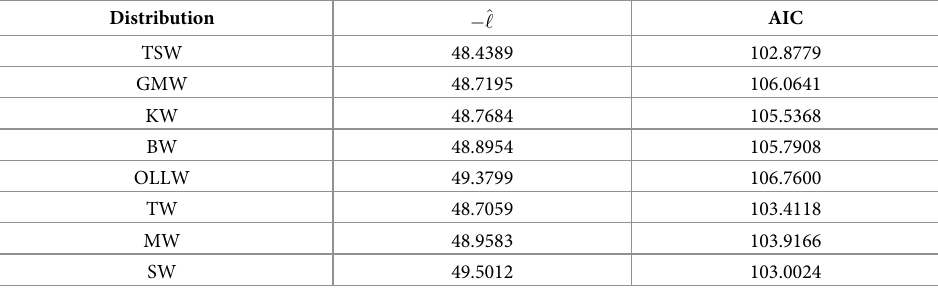
Tables 2 and 3 list the values of the CVM, AD, KS with p-value, and the MLEs and their cor- responding SEs of the models parameters for the first and second data sets, respectively. Tables 2 and 3 indicate that the smallest CVM, AD and KS and the largest KS p-value are for the TSW model; it is the best model with the considered criteria. In particular, it Table 4. The (cid:0) ^ ‘ and AIC for the first data set.